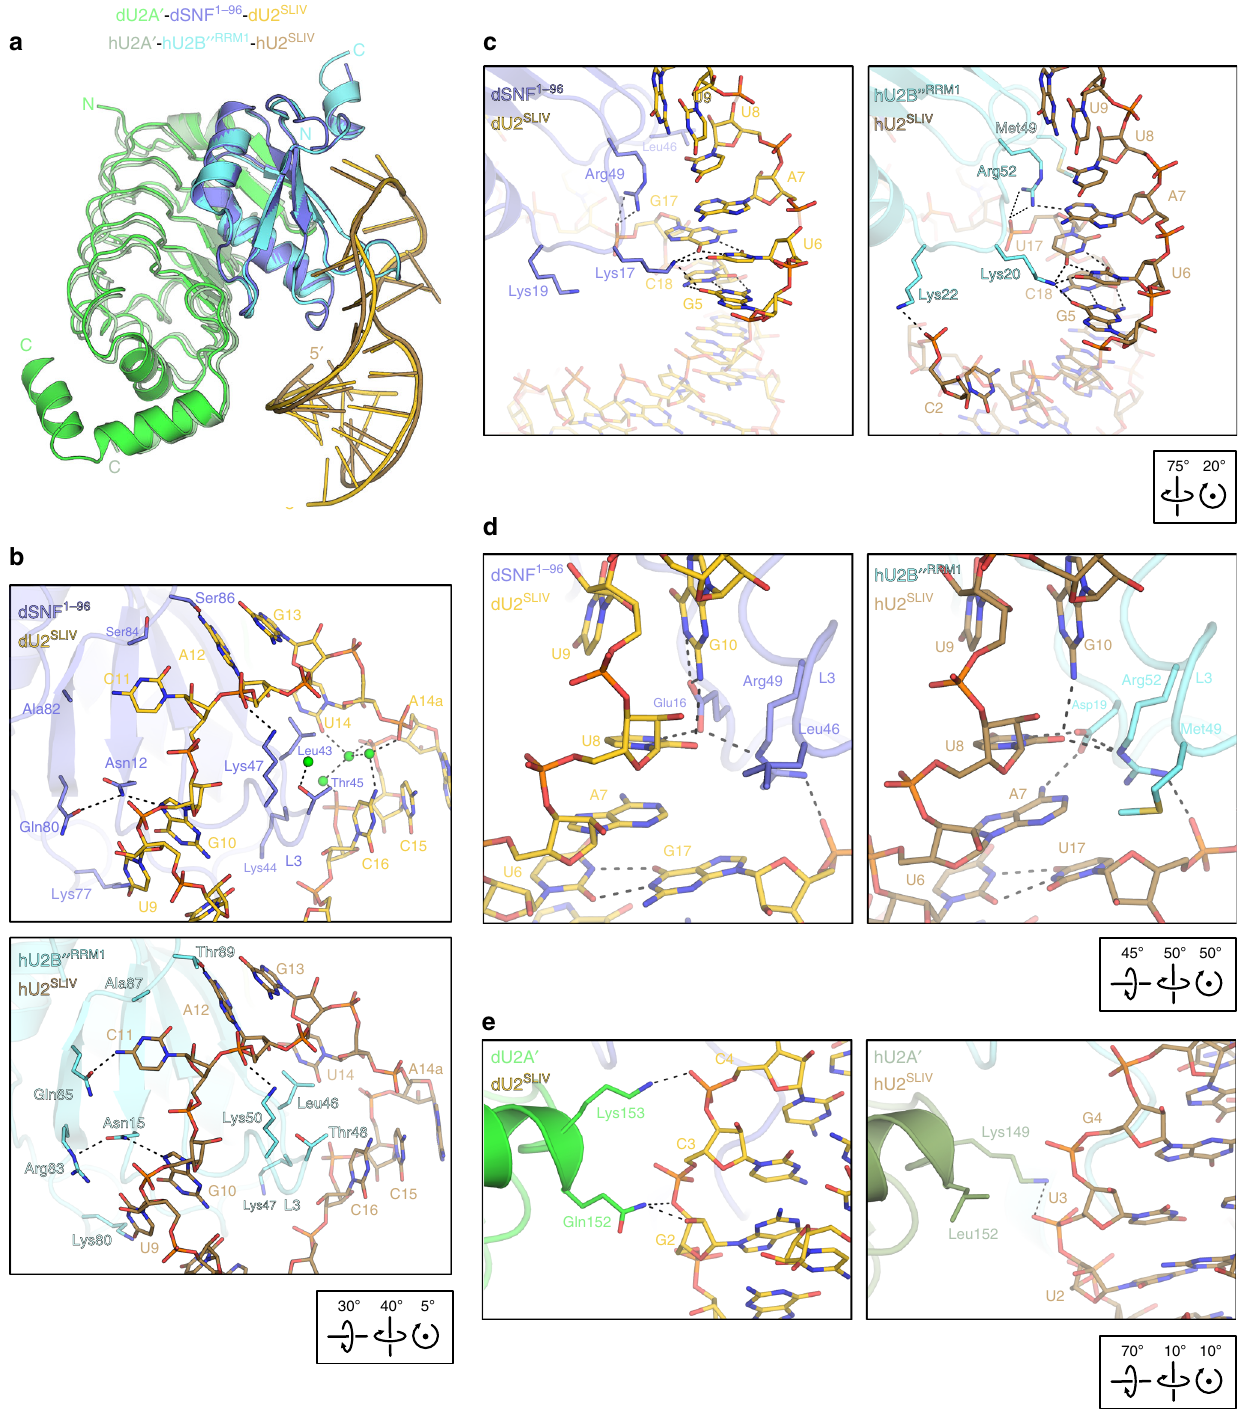
Fig. 7 Comparison of ternary complexes from Drosophila and human. a Ribbon diagram of the hU2A ′ – hU2B ″ RRM1 – hU2 SLIV complex (fern green/cyan/light brown; PDB ID 1A9N 14 ) superimposed on the dU2A ′ – dSNF 1 – 96 – dU2 SLIV complex (green/steel blue/gold) according to the hU2B ″ R RM1 /dSNF 1-96 subunits. The orientation of dSNF 1 – 96 is as in Fig. 1b. b Contacts to the RNA loops in the Drosophila (top) and human (bottom) systems. c Interaction networks around the loop-closing base pairs in the Drosophila (left) and human (right) systems. d Interactions between the loop-closing base pairs and L3 in the Drosophila (left) and human (right) systems. e Contacts of the respective U2A ′ protein to the RNA stems in the Drosophila (left) and human (right) systems. Orientations relative to Fig. 1b are indicated by boxed rotation